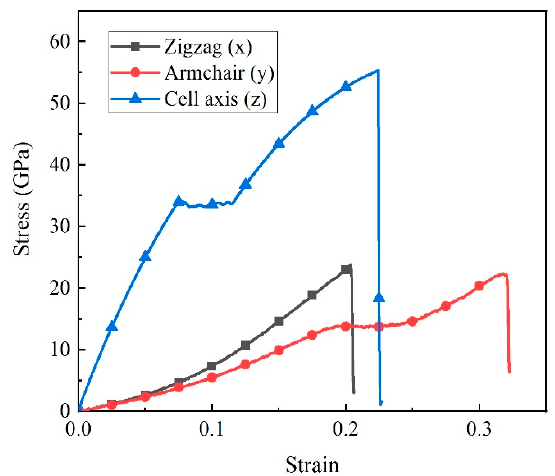
Figure 2. Engineering stress-strain curves of carbon honeycomb for tensile loading along zigzag, armchair and cell axis direction, respectively.